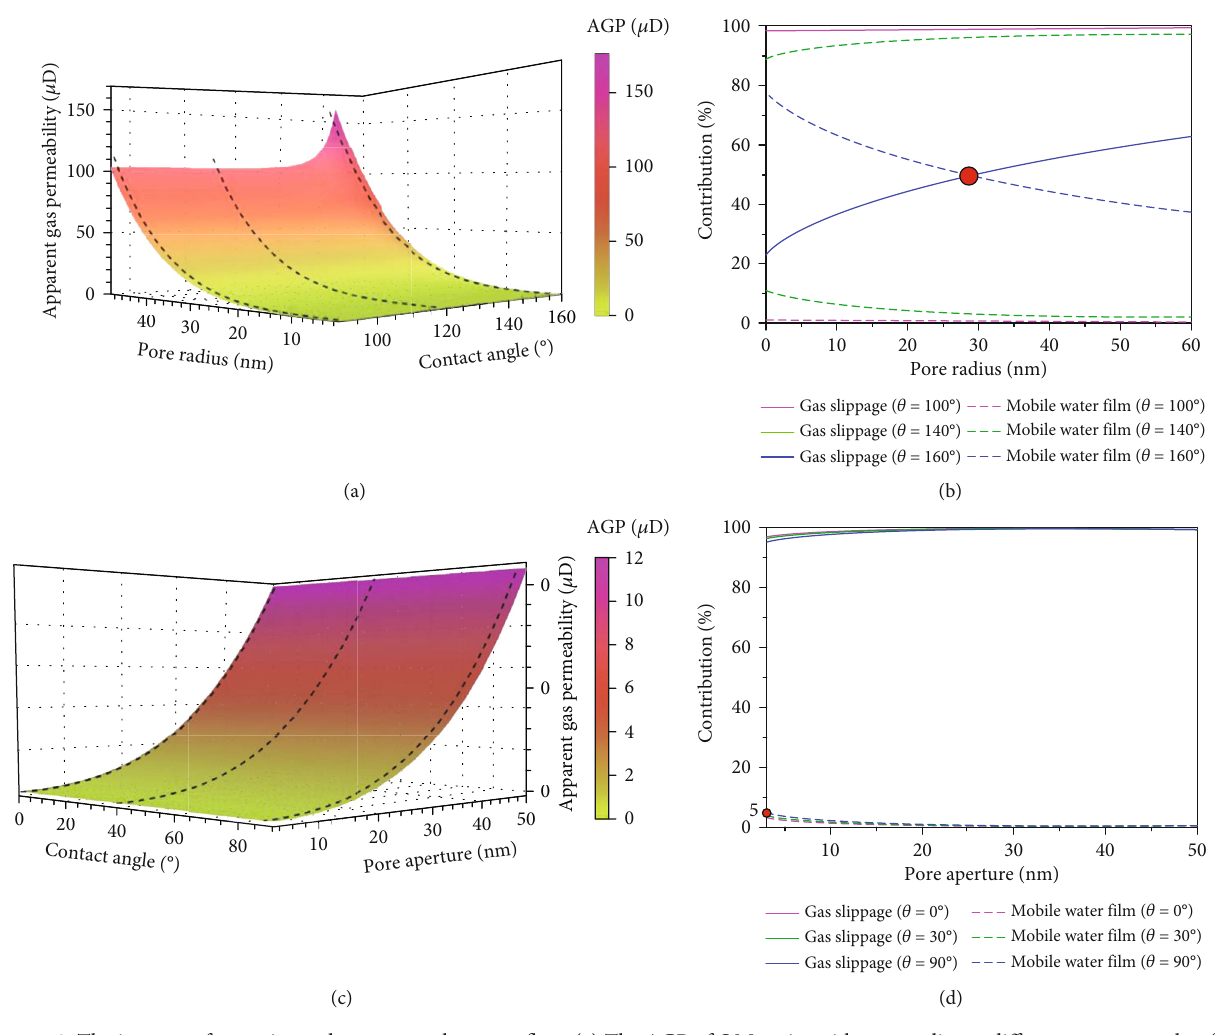
Figure 8: The impacts of pore size and contact angle on gas fl ow. (a) The AGP of OM varies with pore radius at di ff erent contact angles. (b) Contributions of gas slippage and water fi lm mobility to gas fl ow in OM. (c) The AGP of iOM varies with pore apertures at di ff erent contact angles. (d) Contributions of gas slippage and water fi lm mobility to gas fl ow in